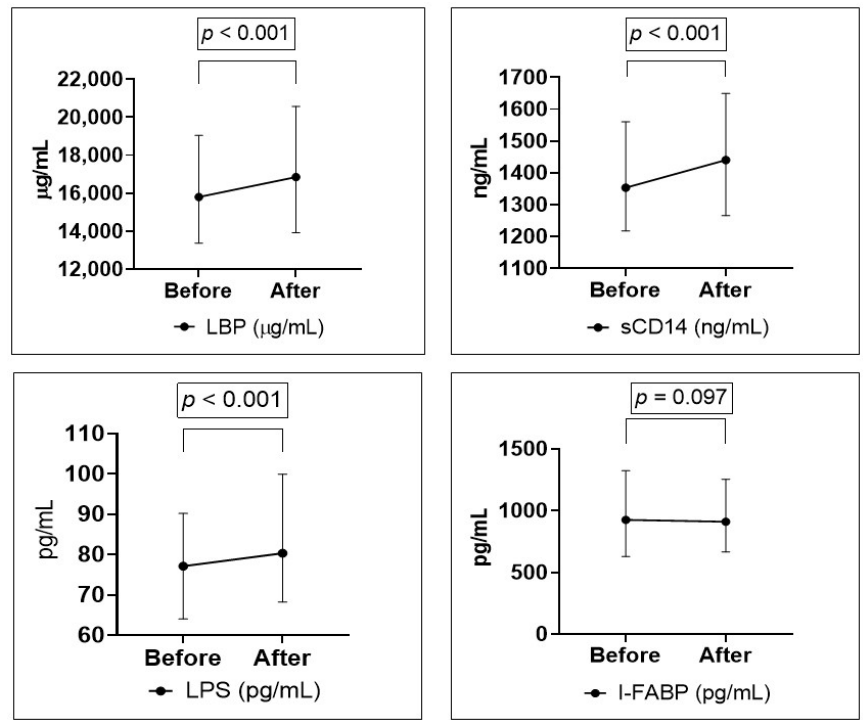
Figure 1. Change in gut leakage markers LBP, sCD14 and I-FABP from before to after exercise in all patients ( n = 287), and LPS in a subset of patients ( n = 101).